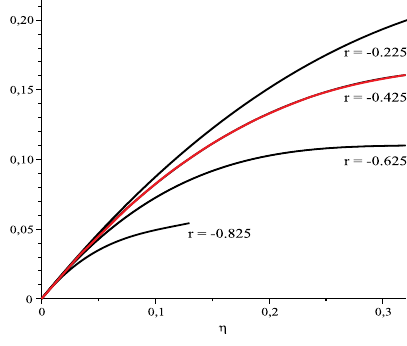
Figure 2. Approximate series solutions of f ( η ) to equation (2.5) and for different values of r when A = 0 and B = 1. The red curve is for r = − 0 . 425.